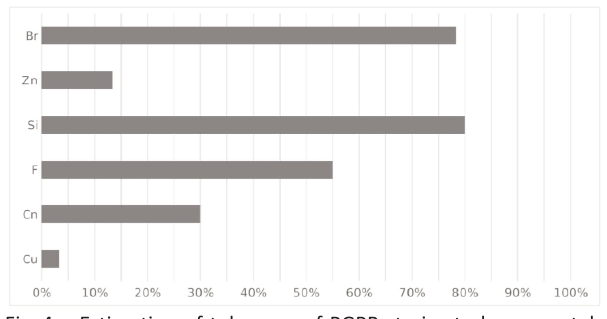
Fig. 4 - Estimation of tolerance of PGPR strains to heavy metals toxicity. Br= Bromine, Zn= Zinc, Si= Silicon, F= Fluorine, Cn= Cyanide, Cu=